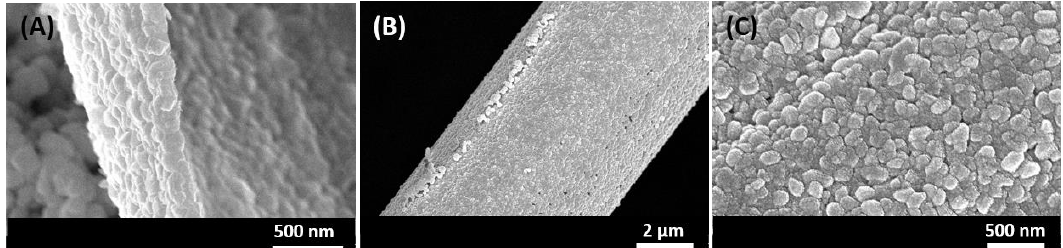
Figure 4. SEM views of the Cr 2 O 3 hollow fiber material: ( A ) thickness and ( B , C ) axial direction views.